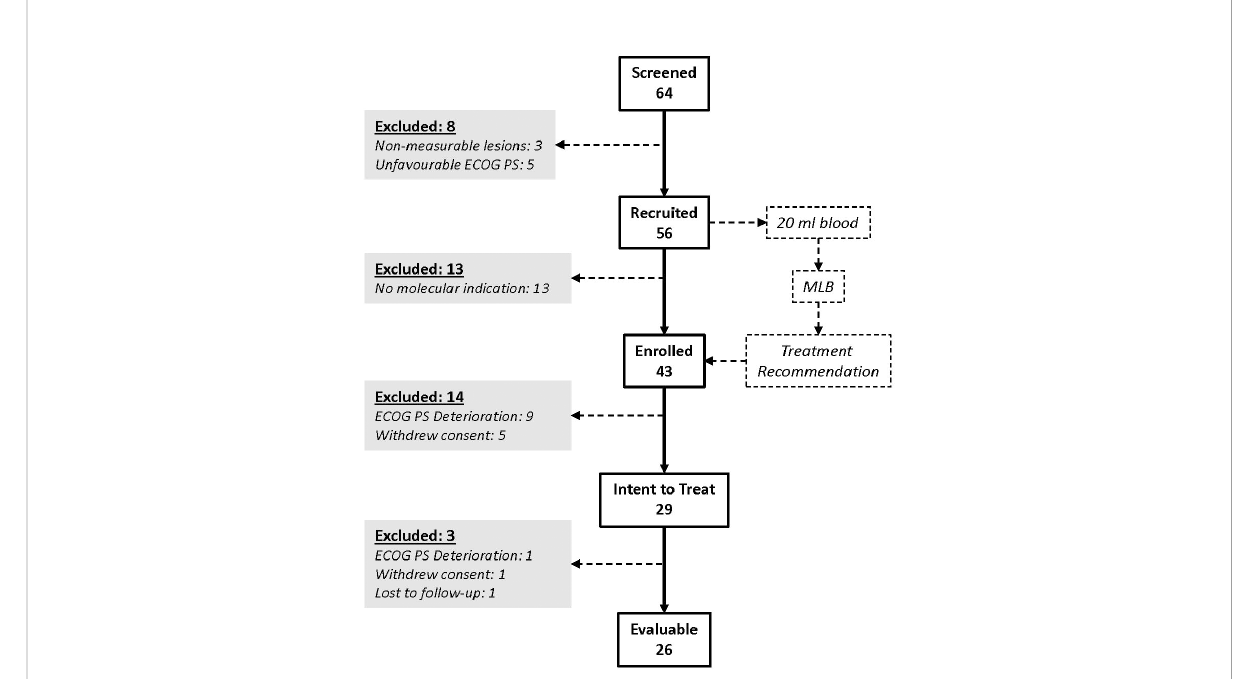
FIGURE 2 LIQUID IMPACT CONSORT Diagram. Among the 64 patients who were screened, 29 eventually started treatment (ITT population) and 26 were fi nally evaluable based on study criteria. Patients provided blood specimens at baseline which were used for multi-analyte liquid biopsy